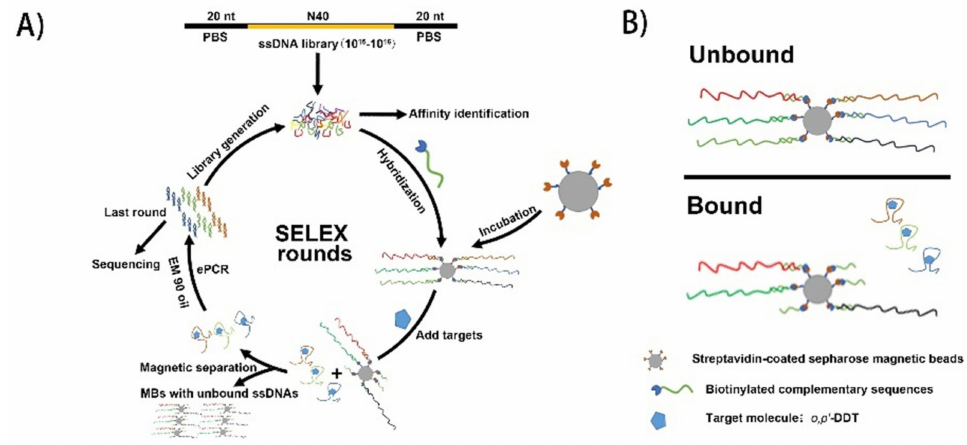
Figure 1. Illustration of the systematic evolution of ligand by exponential enrichment process. ( A ) Library molecules that bind to the target ( o,p’ -DDT) were retrieved and amplified by PCR in one round of SELEX. ( B ) Illustration of the library immobilization process for the modified Capture-SELEX. Biotinylated complementary DNA (cDNA) probes with library ssDNA molecules were first captured on streptavidin coated magnetic beads. Library ssDNA molecules dehybridized by positive target induction were retrieved and subsequently